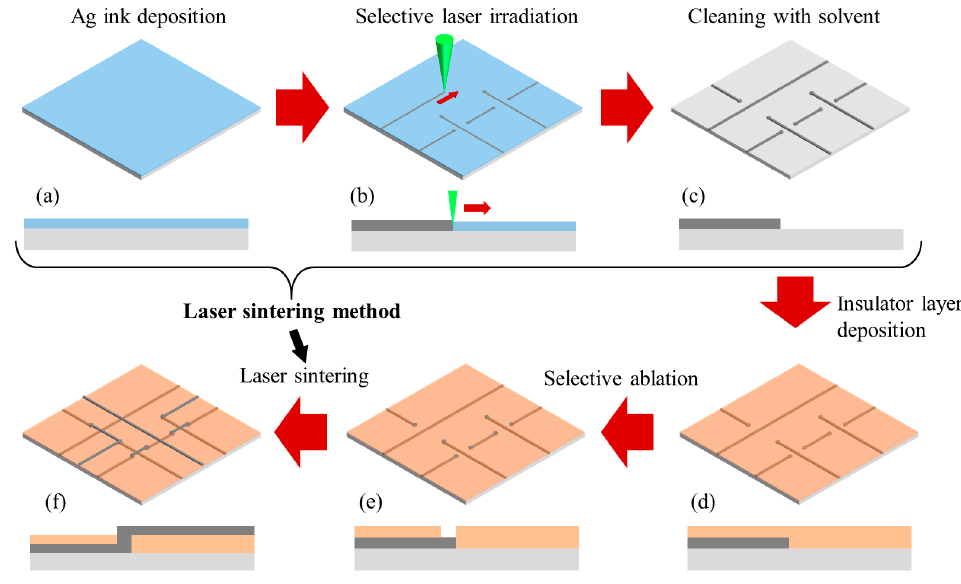
Figure 1. Schematic of the multi-layer patterning process using selective laser sintering and ablation.